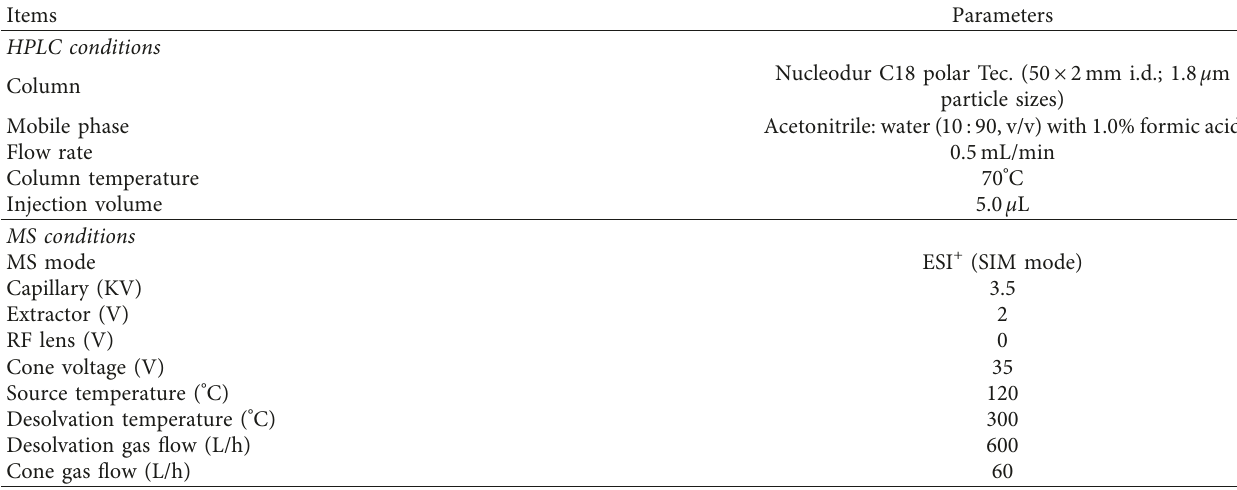
Table 2: Optimum HPLC and MS conditions for determination of theobromine, theophylline, and